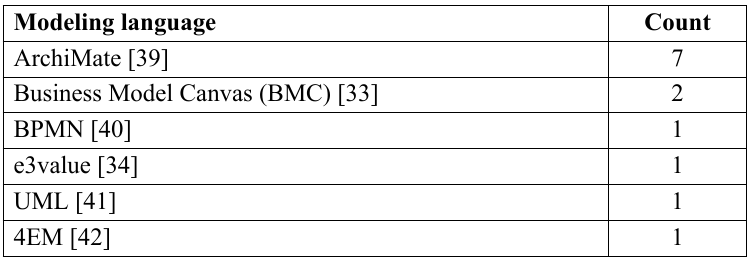
Table 5. Taught modeling